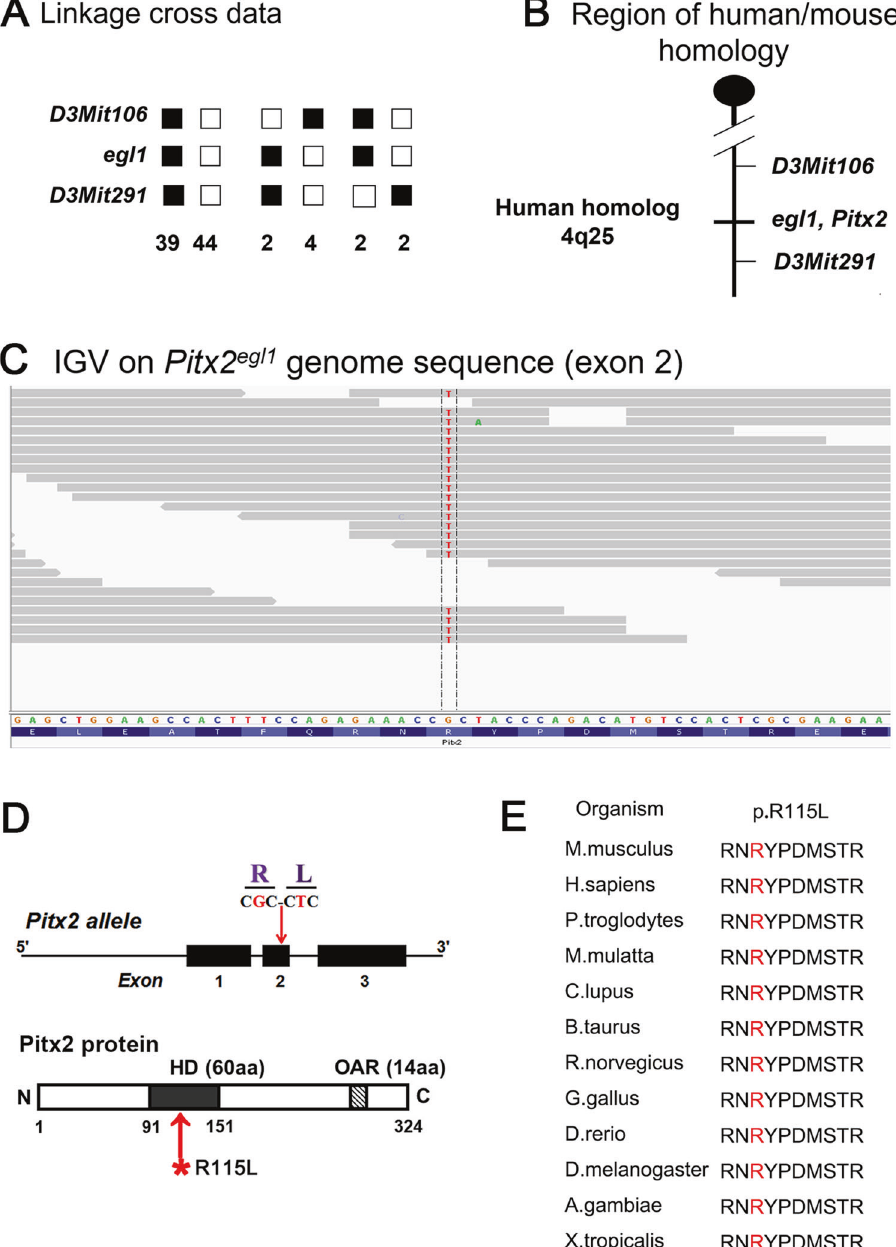
Fig. 2 Identi fi cation of Pitx2 mutation in Pitx2 egl1 mice by whole-exome sequencing. A Genetic and molecular analysis of the egl1 strain. A total of 93 progeny from a egl1/egl1 X ( egl1 /DBA/2J) F1 backcross were genotyped in a genome-wide scan. Linkage to several markers on mouse Chr 3 was observed. The columns of squares represent haplotypes ( fi lled boxes, egl1/egl1 B6 alleles; open boxes, egl1 B6/DBA/2J allele). The number of chromosomes associated with each haplotype is indicated below each column. B Genetic map of Chr 3 in the egl1 region showing the closest markers and the region of human homology. C Integrative Genomics Viewer (IGV) shows the base substitution. D A homozygous missense mutation, c. G344T, p. R115L of the Pitx2 gene was identi fi ed in Pitx2 egl1 mice by whole-exome sequencing (WES). Upper panel: The schematic diagram shows the location of the missense mutation in the Pitx2 gene. Bottom panel: Functional domains of PITX2 protein with the location of the mutations. HD, homeodomain; OAR, opt aristaless and rax. E Protein sequence alignment of amino sequences surrounding the Pitx2 mutation with orthologous sequences from Mus musculus to Xenopus tropicalis. The mutant amino acid residue is in red. Note that the amino acid sequences surrounding the affected amino acid residues are also highly conserved. (Fig. S5A). At 6 weeks, a mild loss of cells in the ganglion cell layer Retinal ganglion cell loss and optic nerve degeneration in (GCL) was observed in mutant mice (Fig. S5B), and this trend Pitx2 KI mice generally progressed with age. To determine whether high IOP leads to optic neuropathy in At 3 months, mutant mice showed a mild thinning of outer and Pitx2 KI eyes, we assessed retinal and optic nerve morphology in inner nuclear layers (Fig. S6A, B), accompanied by a 61.2% histological sections ON. Eyes of P16 mutant mice, an age prior decrease in GCL cell number compared to that of controls to IOP elevation, exhibited a normal retinal layer morphology